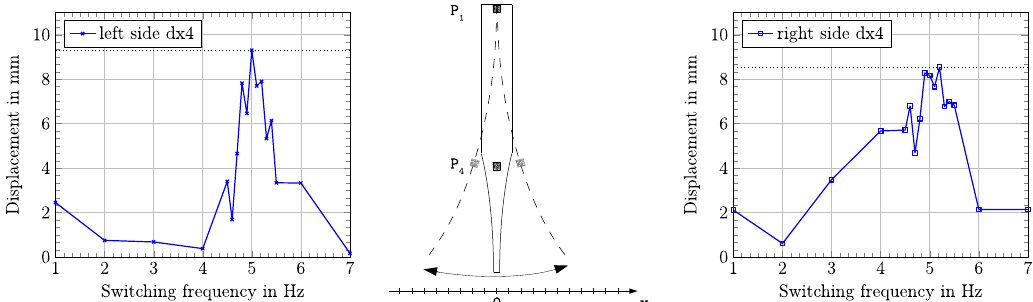
Figure 14. Results for the measured deflections dx4 to the left and to the right side over the investigated frequency range at a driving voltage of 4000 V.